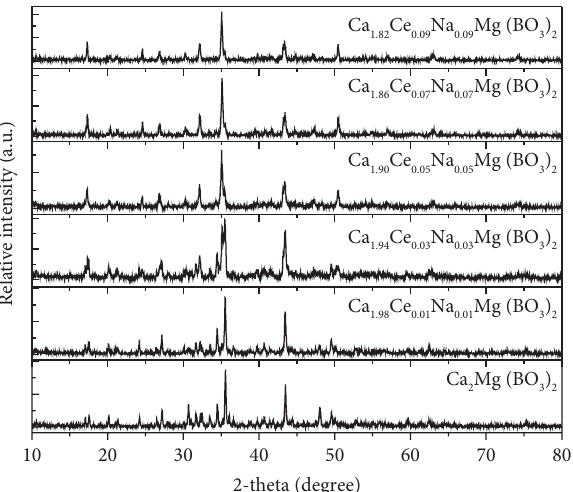
� 0, 0.01, Figure 2: UV-Vis emission spectra of Ca at